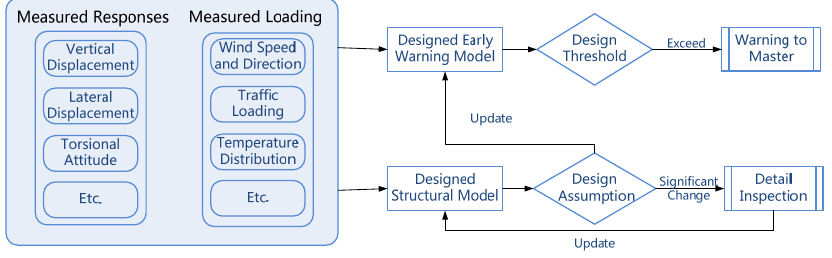
Figure 7. The flow chart of building block for GeoSHM Module Four.